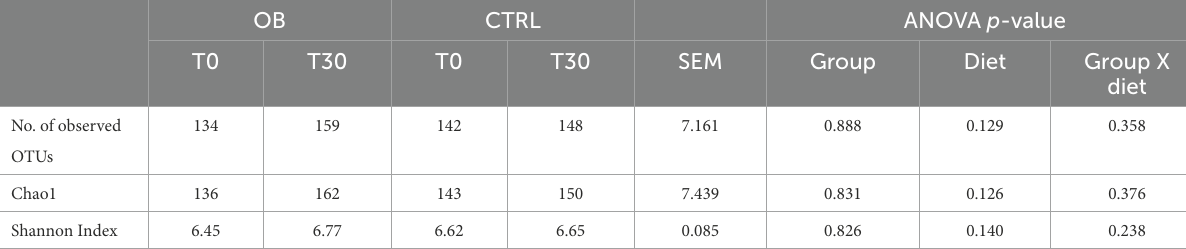
TABLE 3 Alpha-diversity indices of fecal microbiota of obese ( n = 16) and lean dogs ( n = 15) fed the same experimental diet, without caloric reduction, for 30 days (phase 1 of the